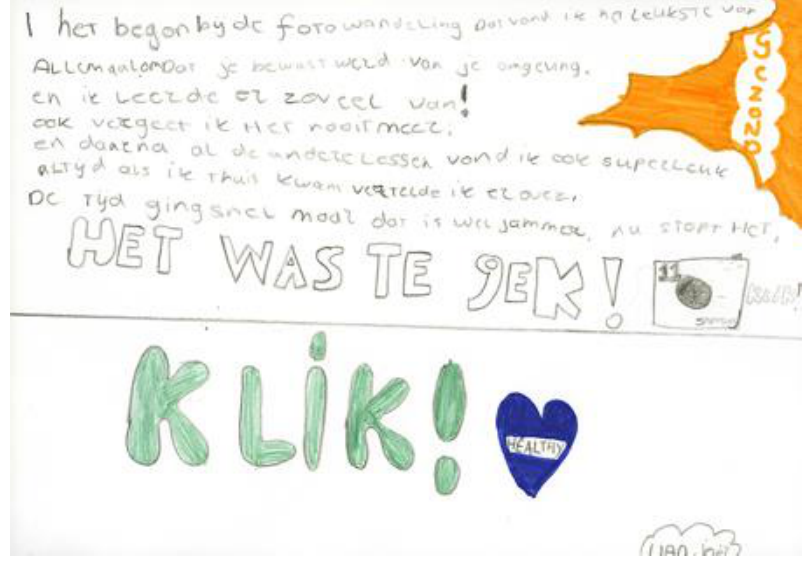
Figure 5. KLIK was te gek! (KLIK was awesome!).